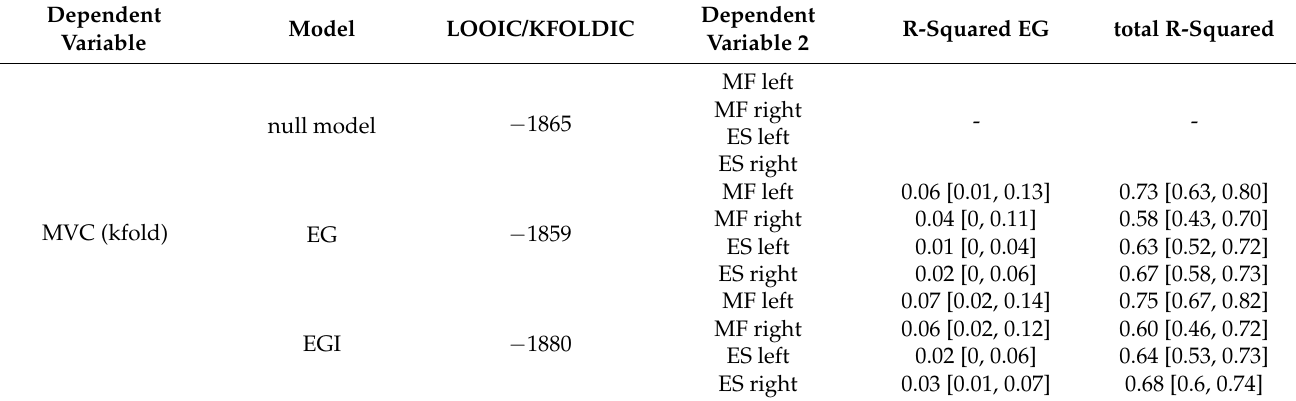
Table 2. Summary of regression models’ fitness to the data used for testing the research Hypothesis